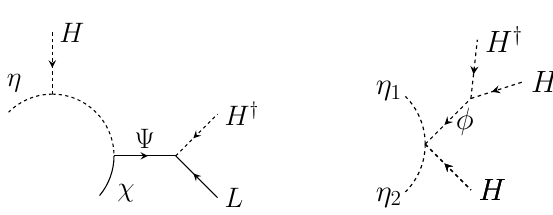
Figure 8 . Structures that appear in topologies T12 (left) and T13 (right) which require at least a quadruplet and a singlet running inside the loop to avoid lower order contributions. For discussion see